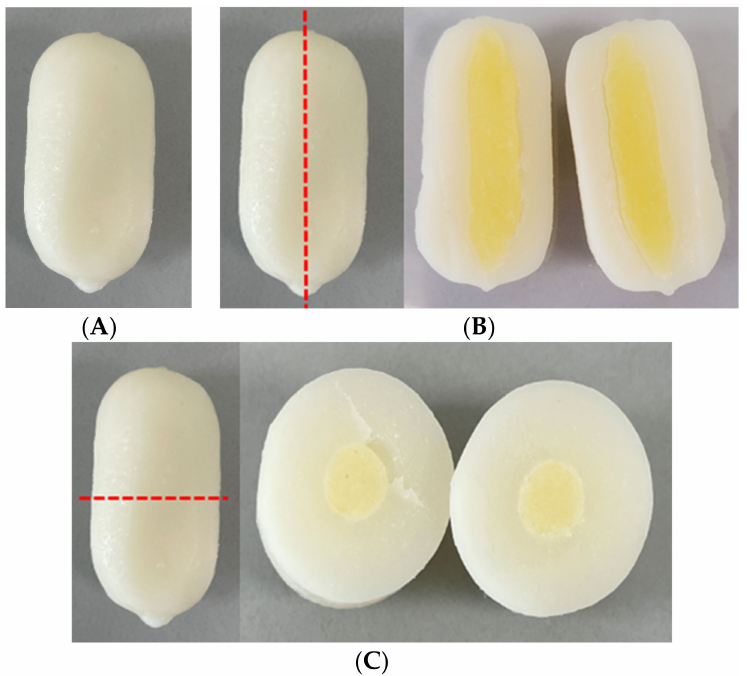
Figure 1. Structure of cheese- ddukbokki rice cake: ( A ) Whole product shape, ( B ) vertical section, ( C ) horizontal